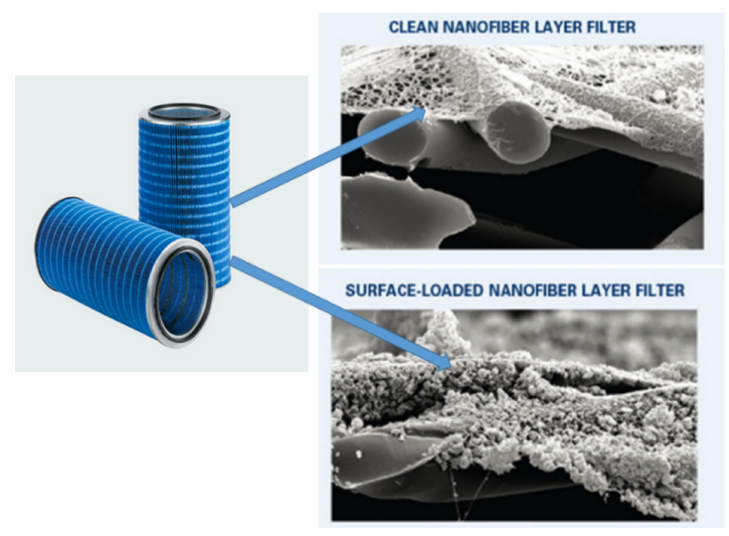
Figure 4. Ultra-web ® filter media by the Donaldson company. Figure is adapted and modified from